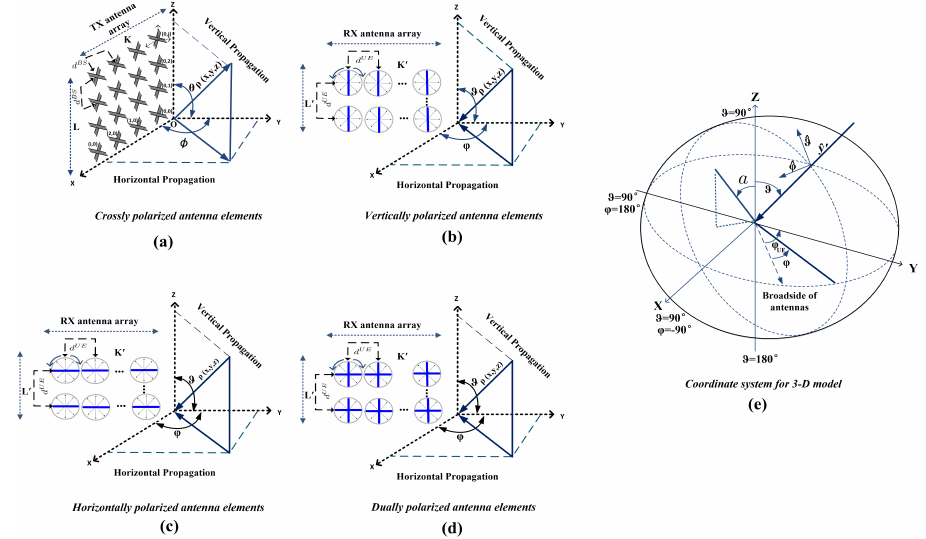
Figure 1. Detailed of antenna configuration X Pol , V, H, and V/H polarizations of an antenna elements in the horizontal and vertical